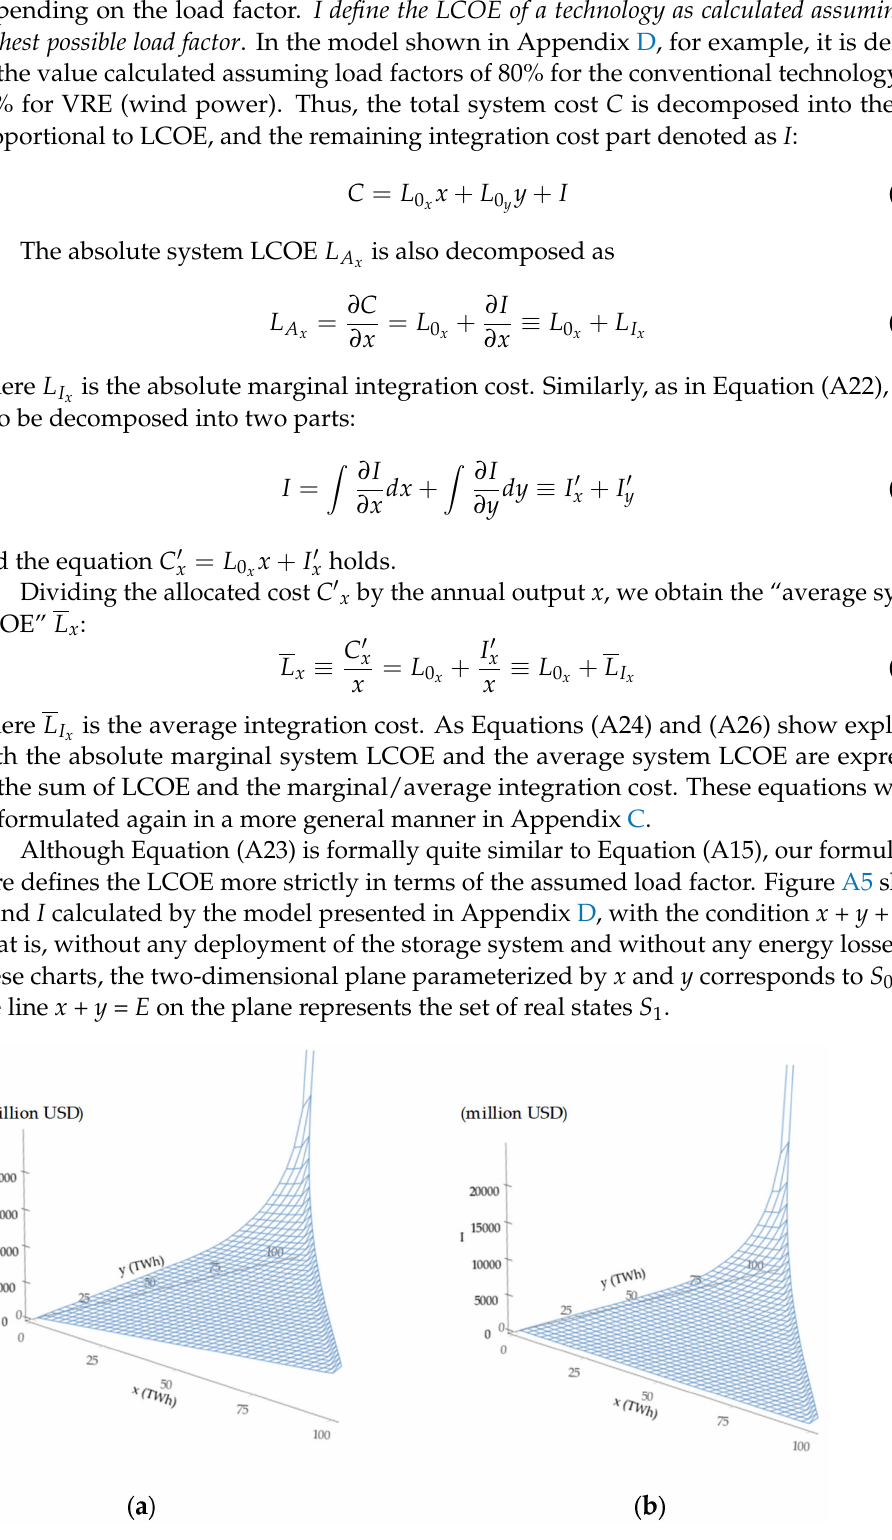
Figure A5. Illustration of the total cost C and the integration cost I . ( a ) C ; ( b ) I